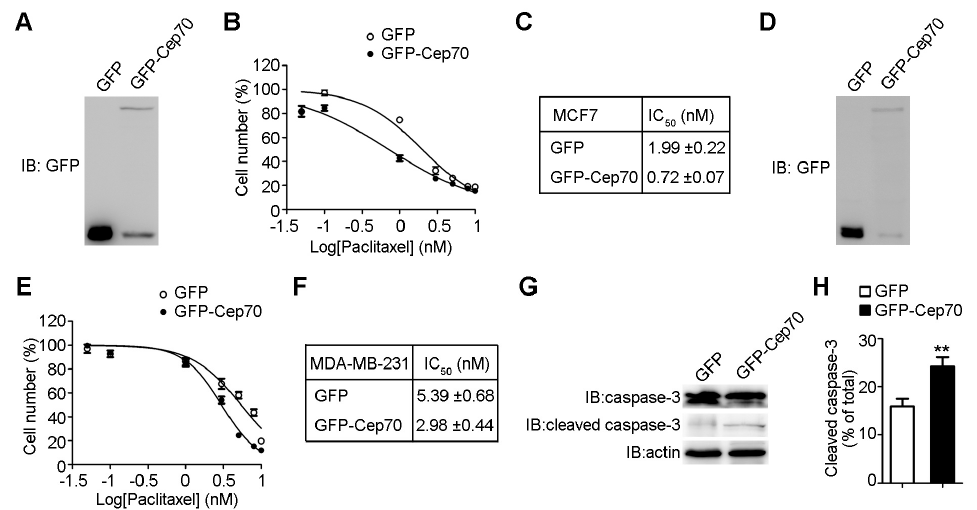
Figure 2. Cep70 overexpression enhances the sensitivity of breast cancer cells to